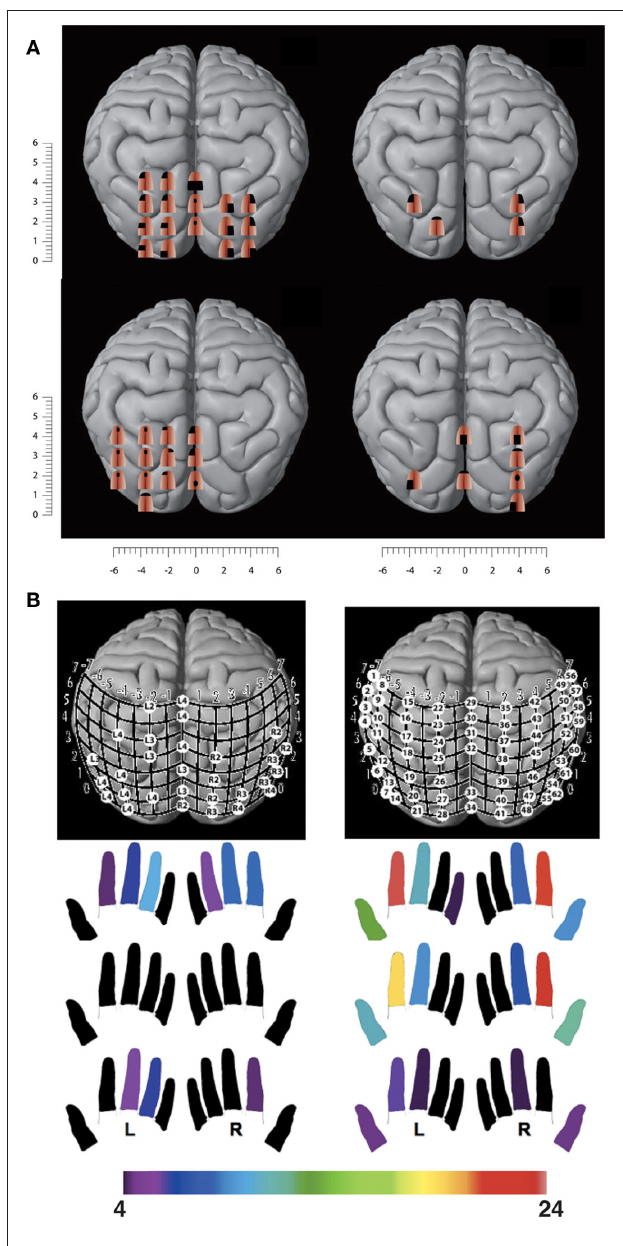
Figure 5 | TMS of the visual cortex in congenitally blind subjects induces tactile sensations. (A) TMS-induced tactile sensations referred to the tongue in congenitally blind subjects following a 1-week training with the TDU. (B) TMS-induced tactile sensations referred to the fingertips in two congenitally blind proficient Braille readers. The color map below indicates the fingers in which the subject experienced TMS-induced tactile sensations. The number of visual cortex sites from which paresthesiae could be induced in a particular finger is color-coded, with red indicating the highest number of cortical sites that induced paresthesiae in a particular finger and purple the lowest number (adapted after Kupers et al., 2006; Ptito et al.,